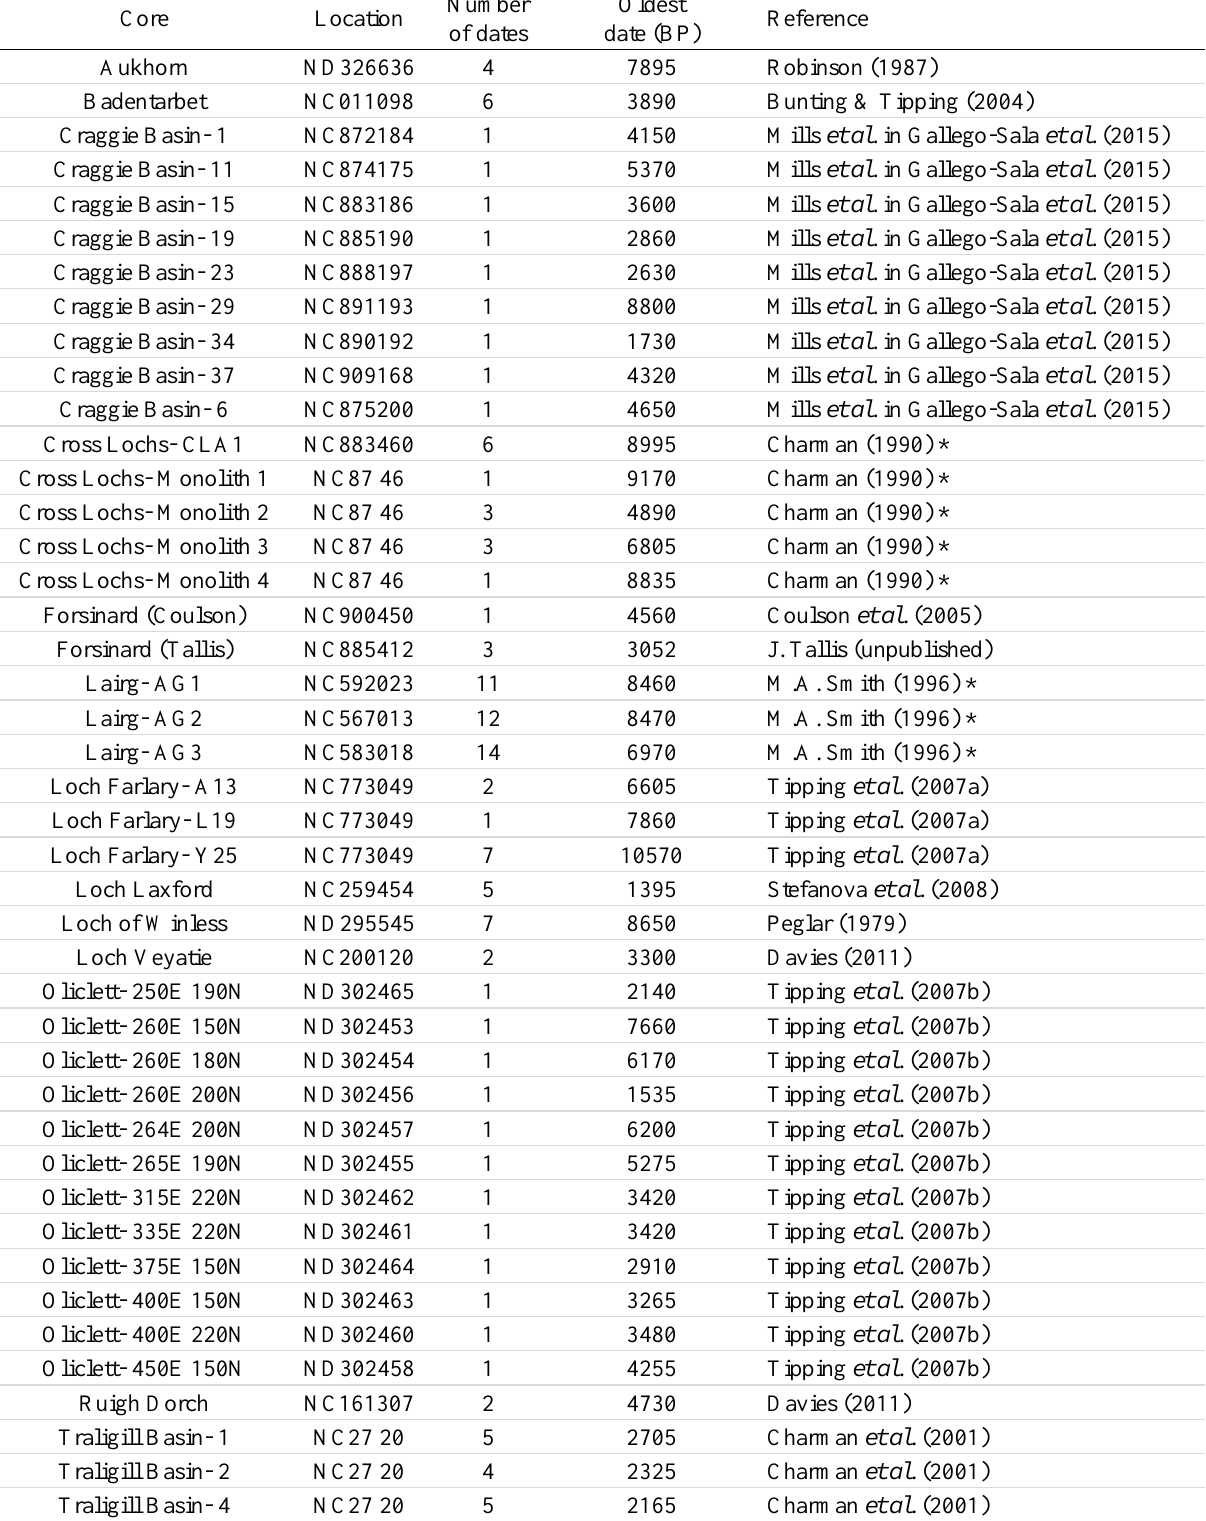
Table 3. Details of radiocarbon dated peat core records used in this study listing core name (as defined in original study), location (UK Ordnance Survey coordinates), number of dates, age of oldest date on peat (uncalibrated 14 C years BP) and original reference with * indicating an unpublished thesis. Core locations are based on original coordinates or our interpretations of information provided in the original reference. Note that some cores are discussed in more than one reference; we make no attempt to identify all relevant